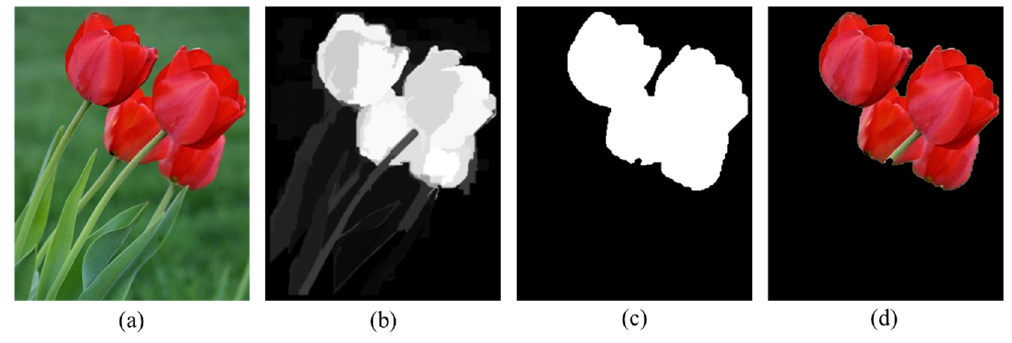
Figure 1. Example of the proposed method: ( a ) input image, ( b ) saliency map, ( c ) saliency cuts, ( d ) Salient objects.